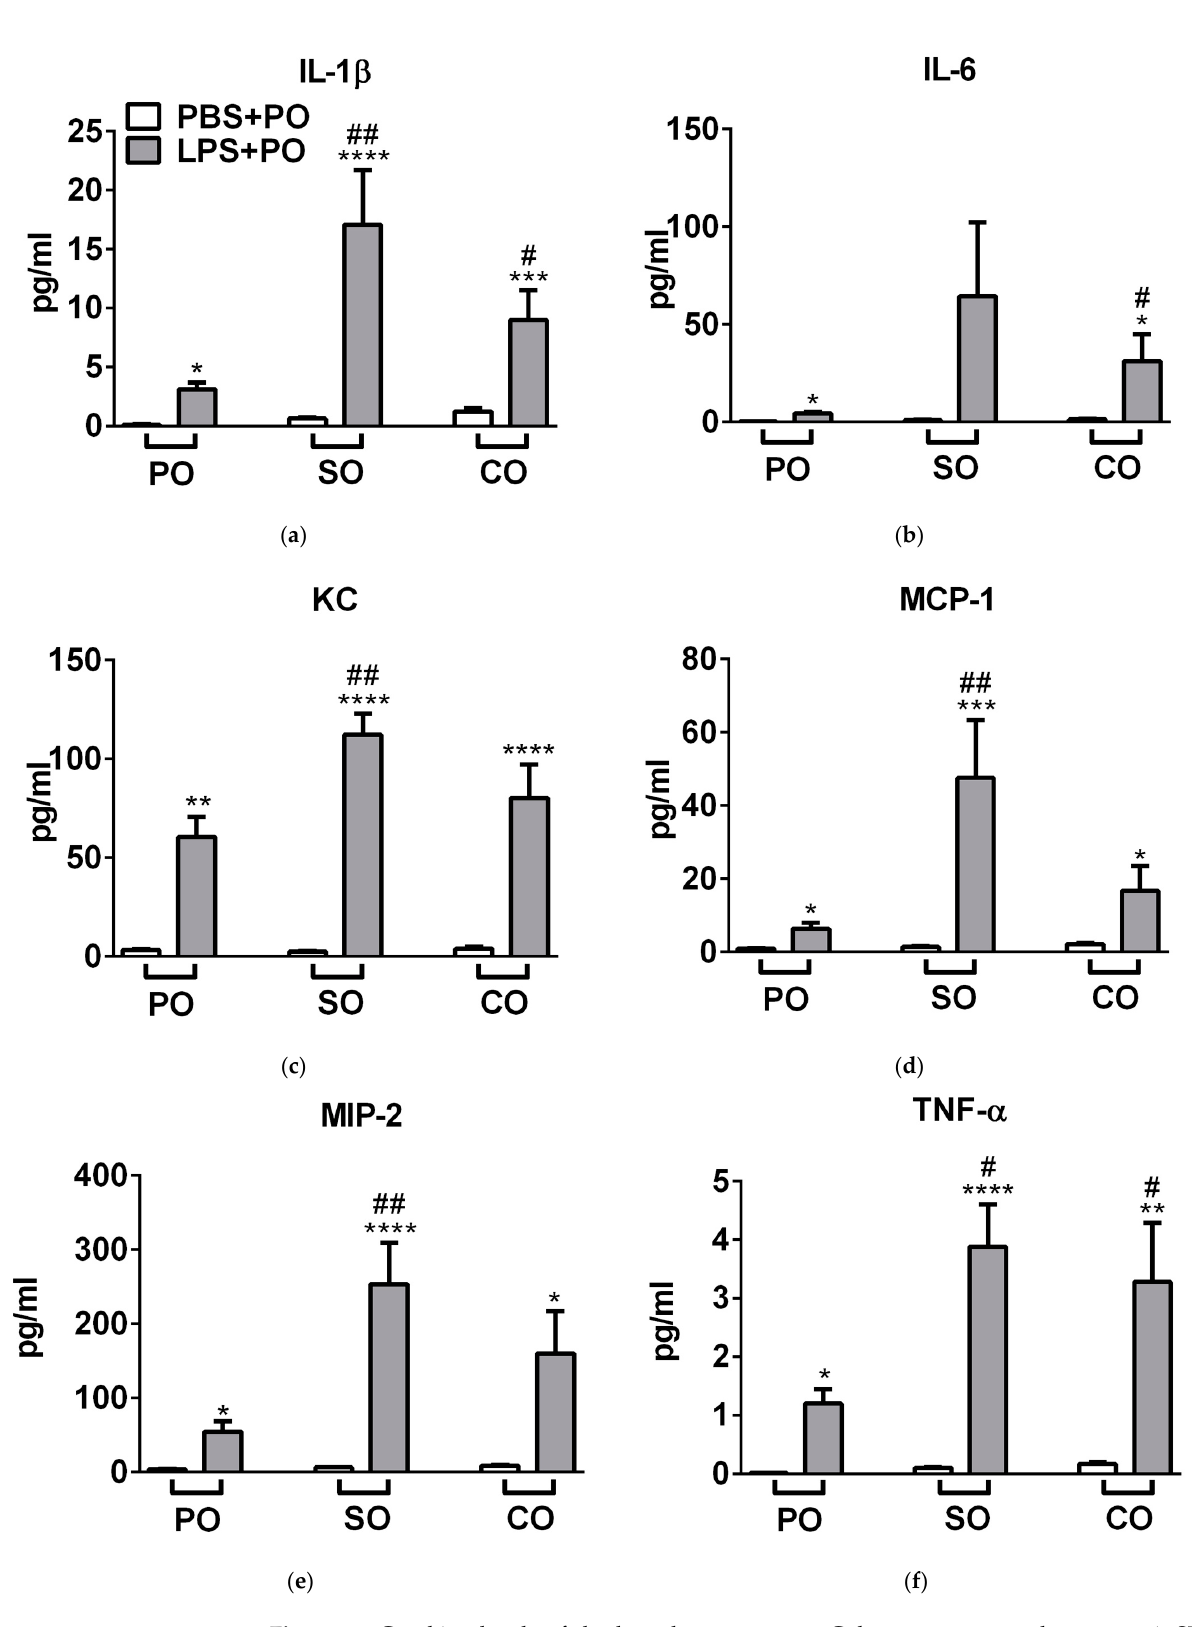
Figure 5. Cytokine levels of the lung homogenates. Columns represent the means ± SEM of n = 6–8 mice/group (* p < 0.05, ** p < 0.005, *** p < 0.0005, **** p < 0.0001 vs. respective PBS-treated group, # p < 0.05, ## p < 0.005 vs. LPS-PO-treated mice; two-way ANOVA followed by Tukey post-test).